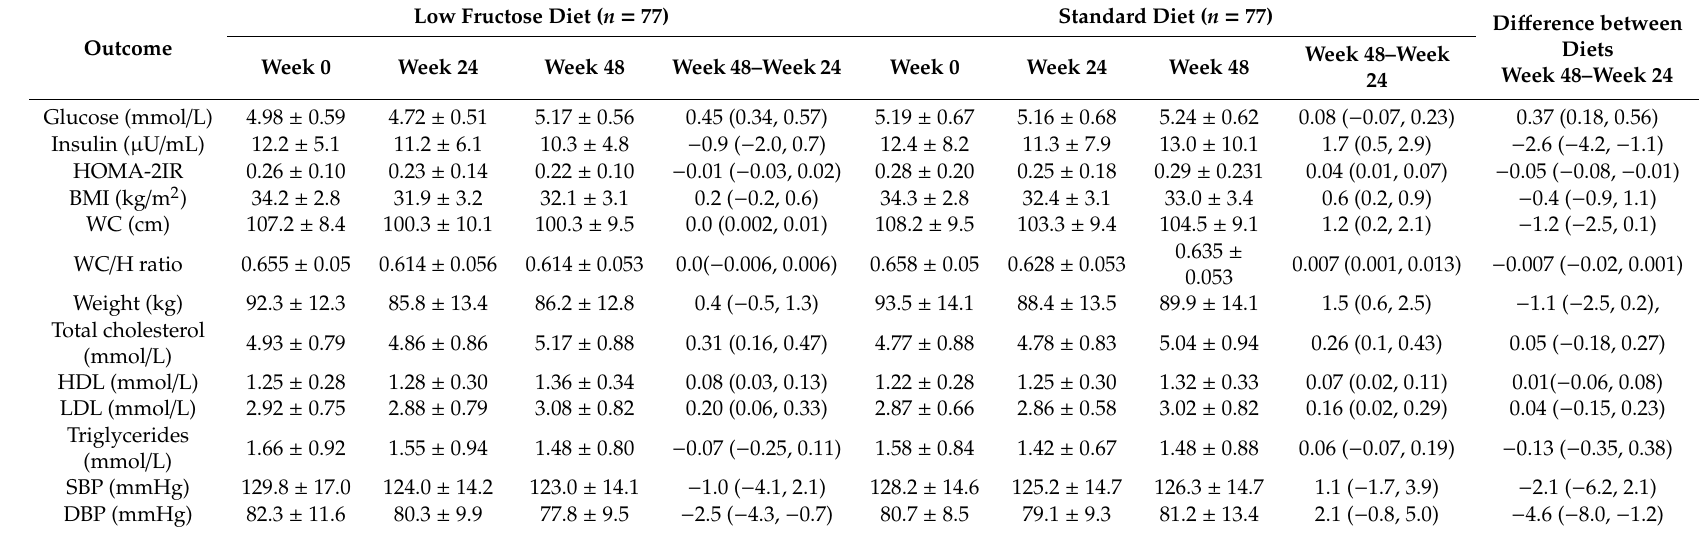
Table 5. Di ff erences between week 48 and week 24 within and between groups for primary and secondary outcomes. Values of week 0 as reference.